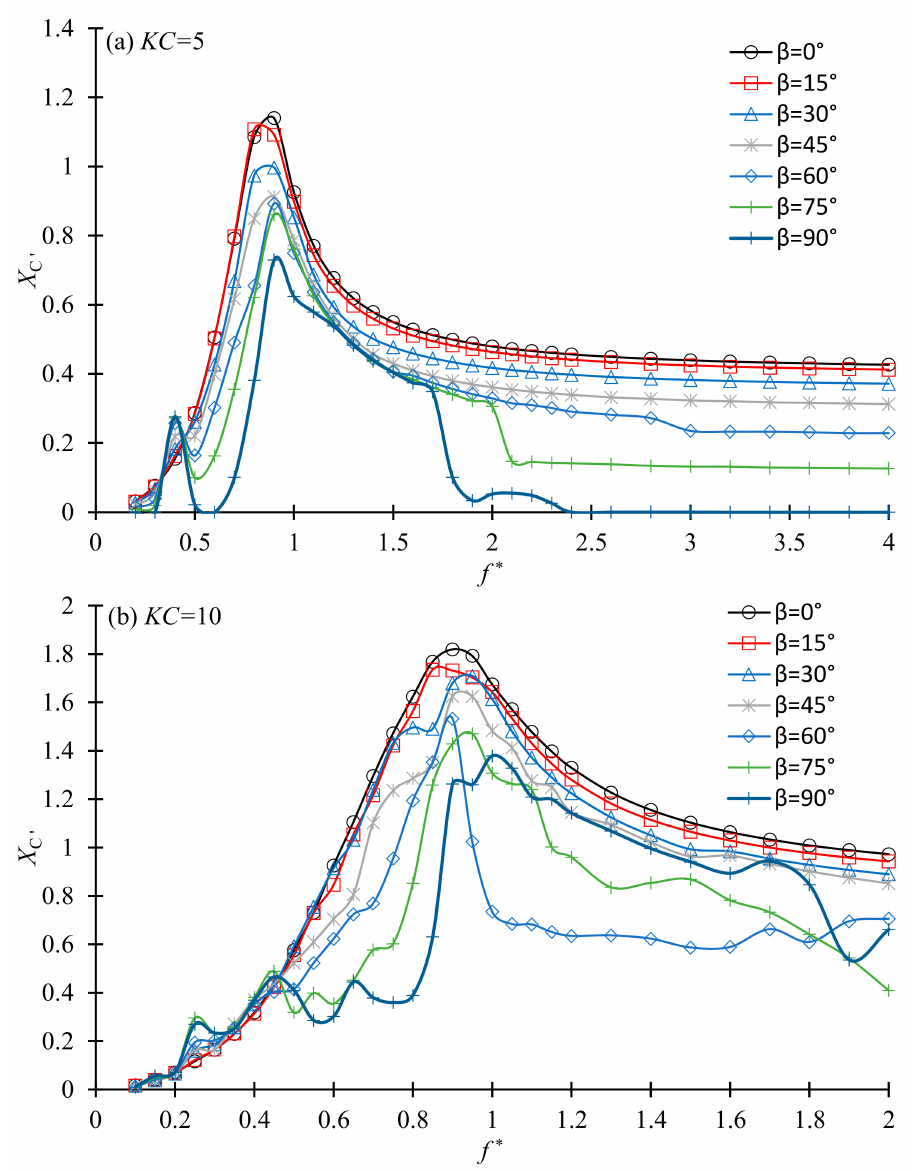
Figure 15. Variation in the standard deviation of the vibration displacement with the frequency